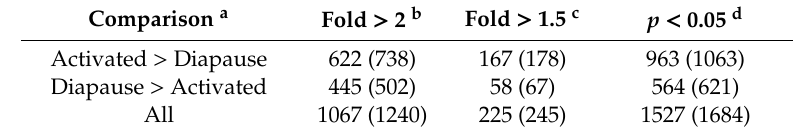
Table 1. Number of differential expressed genes (DEGs) in uterus of diapause and 5 days after embryo activation. Comparison a Fold > 2 b